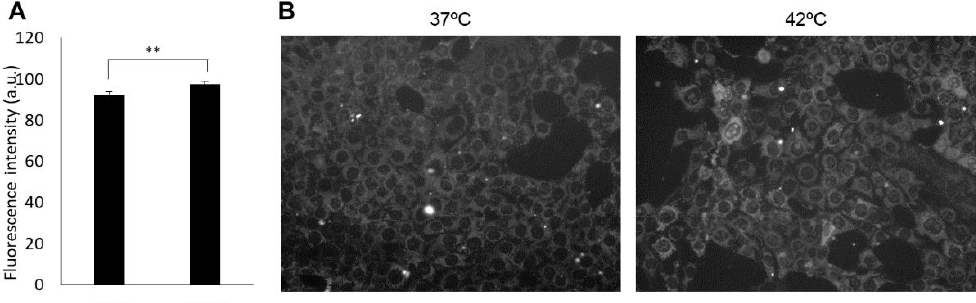
Figure 2. The fluorescence intensity of MitoSOX. ( A ) Intracellular fluorescence intensity detected using a microplate reader. ( B ) Fluorescent microscopy utilized to assess cellular uptake of MitoSOX. Data are expressed as means ± SD ( n = 4). ** p < 0.01. Student’s t -test.